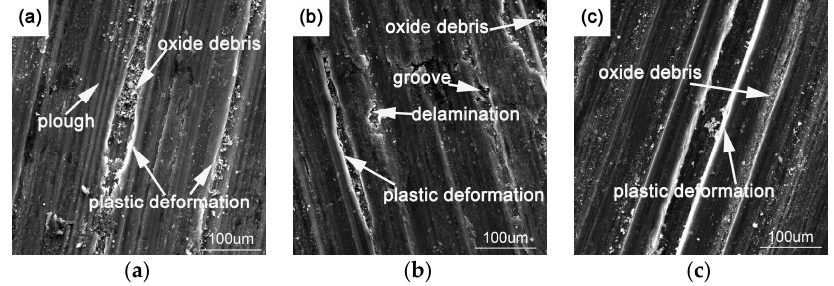
Figure 16. the worn surface of AZ91-1.0%Pr alloys with solution heat treatment under different loads ( a ) 30 N, ( b ) 60 N, ( c ) 90 N.